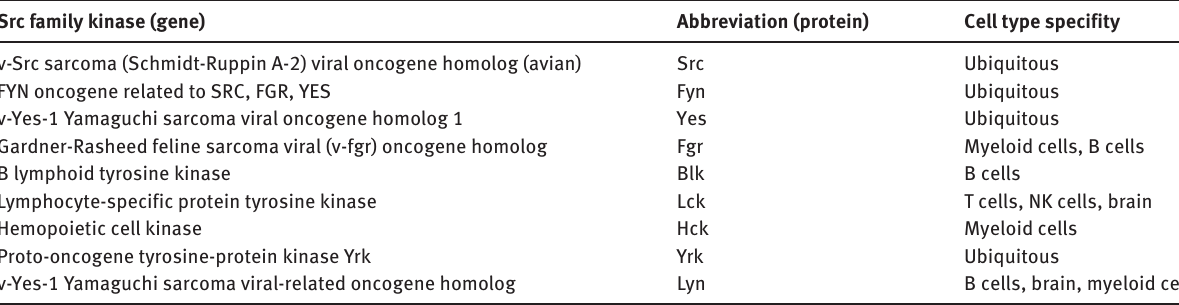
Table 1 Expression of Src family kinases. Src family kinase (gene)